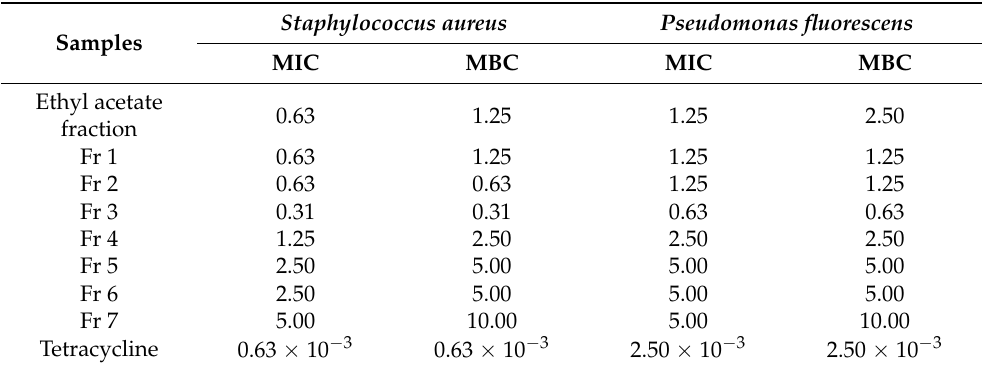
Table 2. MIC and MBC of the ethyl acetate fraction and its sub-fractions from pickled and dried mustard.